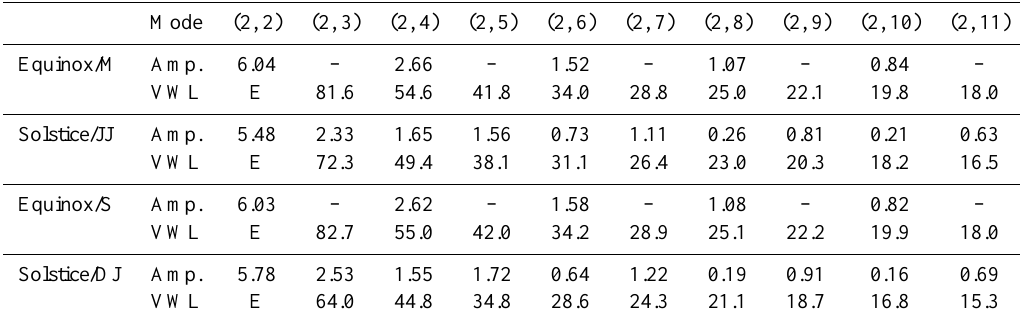
Table 1b. The amplitudes (Amp.) (Kday − 1 ) and the global averaged vertical wavelength (VWL) (km) of the semidiurnal heating Hough modes near the peak ( ∼ 45km) at 4 seasons.